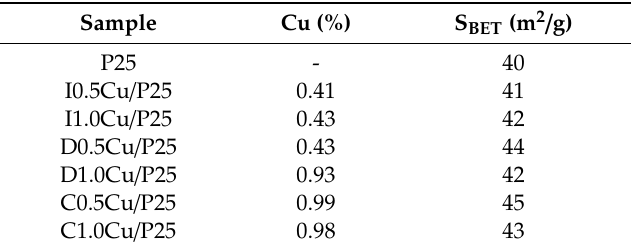
Table 3. Cu actual loading (%) determined by FAAS and specific surface area (S BET ) by nitrogen physisorption.